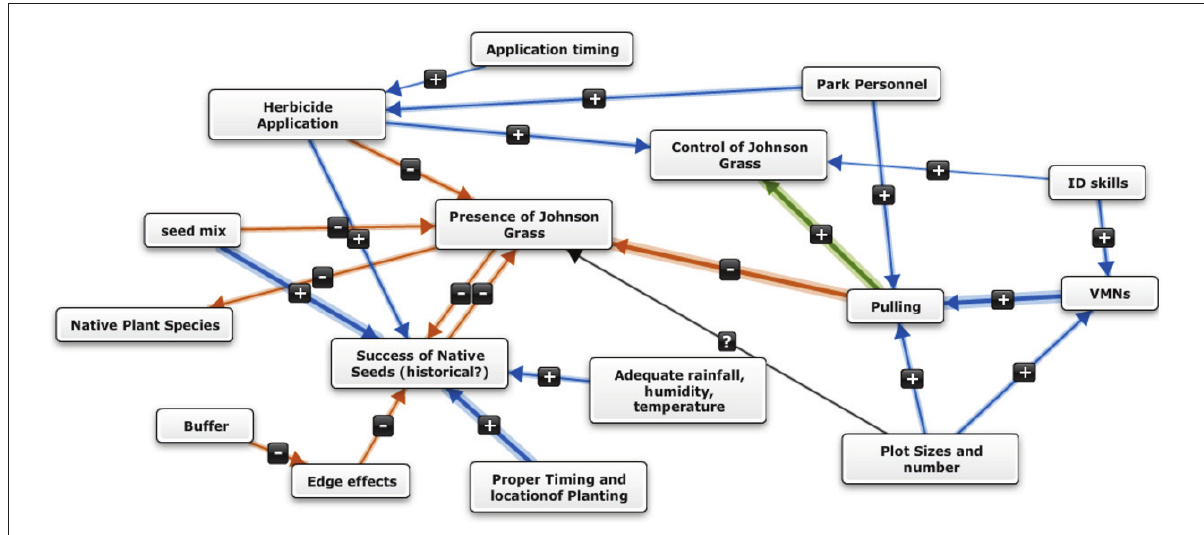
Figure 1: Collaborative Mental Model for a co-created project involving invasive exotic Johnson grass (Sorghum halepense) removal at a national monument